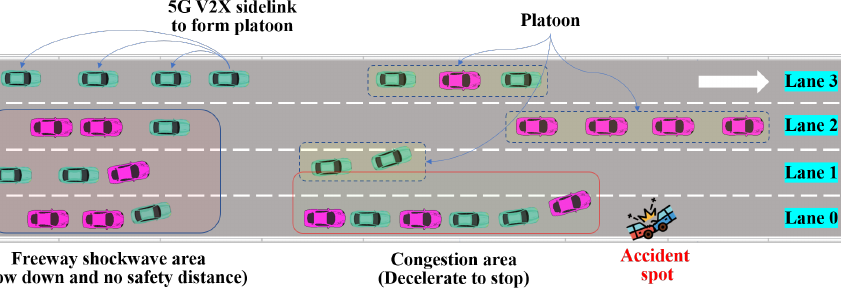
Figure 1. The illustration of traffic congestion caused by a vehicle accident on a multi-lane freeway,